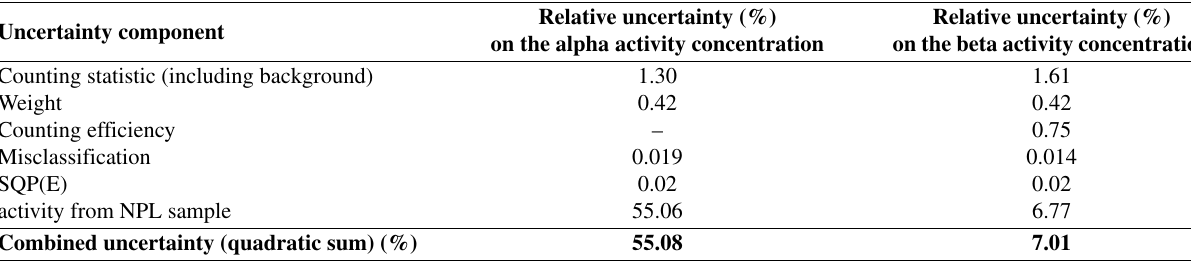
Relative uncertainty (%) on the alpha activity concentration on the beta activity concentration